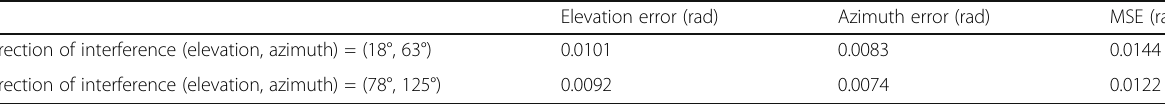
Elevation error (rad)